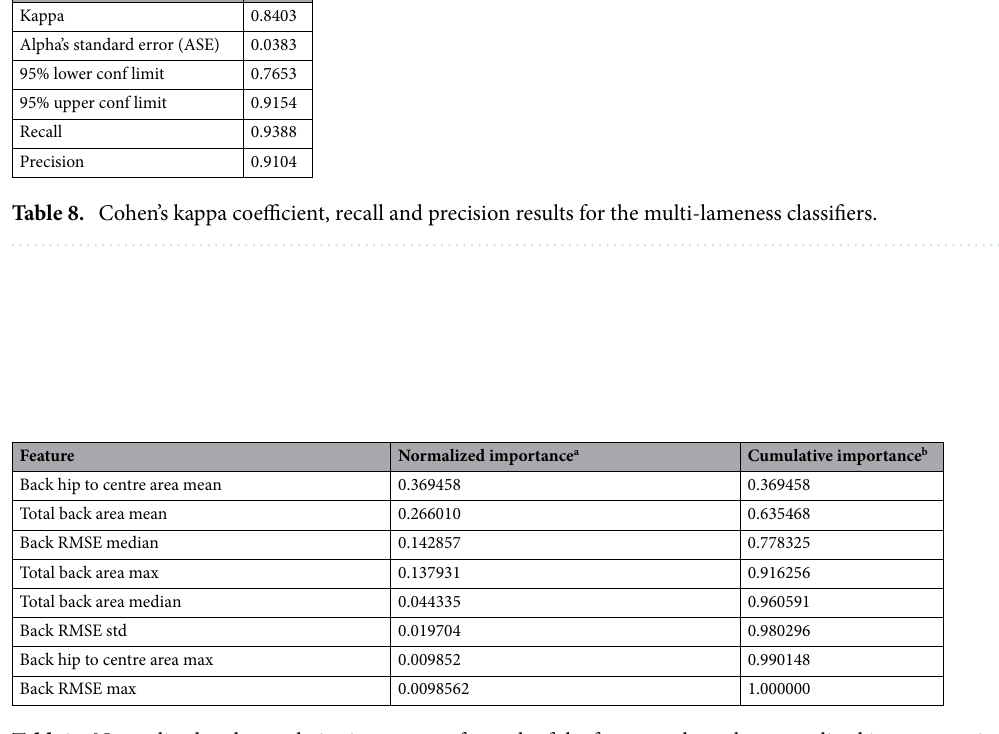
Table9. Normalized and cumulative importance for each of the features where the normalized importance is greater than zero. a,b The importance’s were calculated using boosting ensemble tree-based machine learning as a factor of how much they contributed to the correct binary classification where the labels were ‘little or no lameness’ with assigned mobility scores of 0 and 1 and ‘Clearly lame’ with assigned mobility scores of 2 and 3.